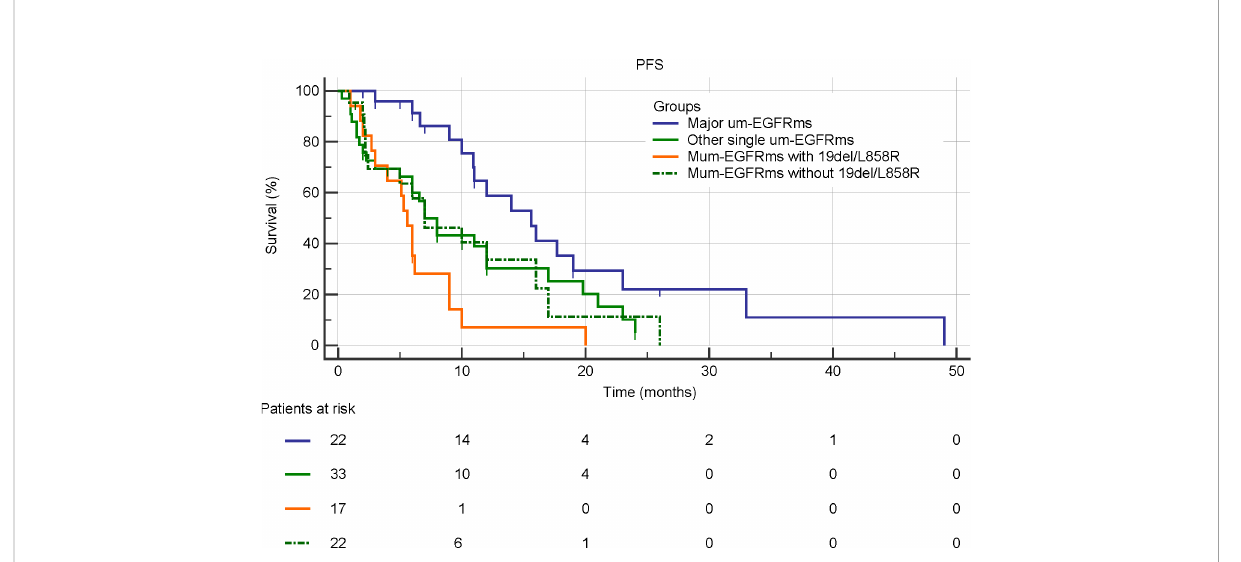
FIGURE 8 Kaplan-Meier curves for PFS in subgroup analysis according to mutation patterns.